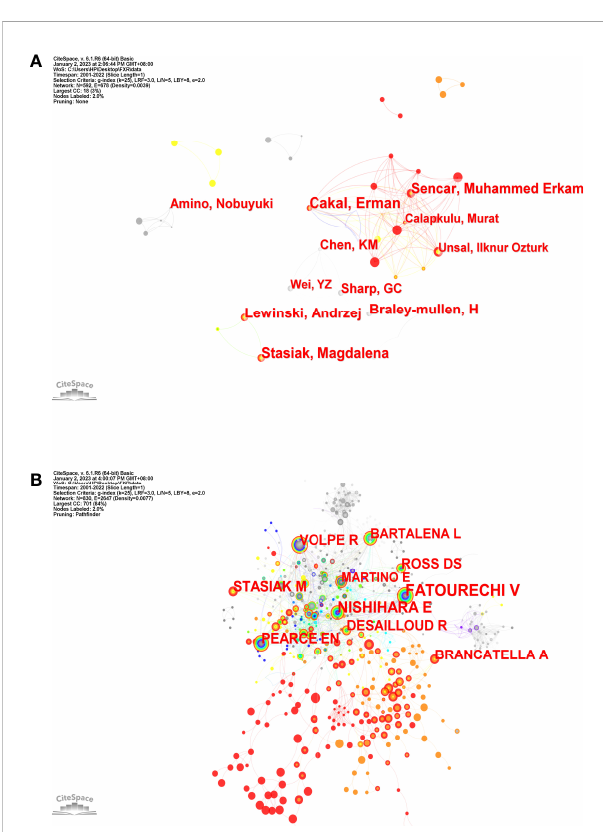
FIGURE 5 The network maps (A) Authors; (B) Co-cited authors. The size of node indicates the number of articles published by a certain author, and the links between two nodes mean a collaboration between each other (A) . The size of node indicates the co-cited frequency of a certain author, and the links between two circles mean a co- citation relationship between authors (B)